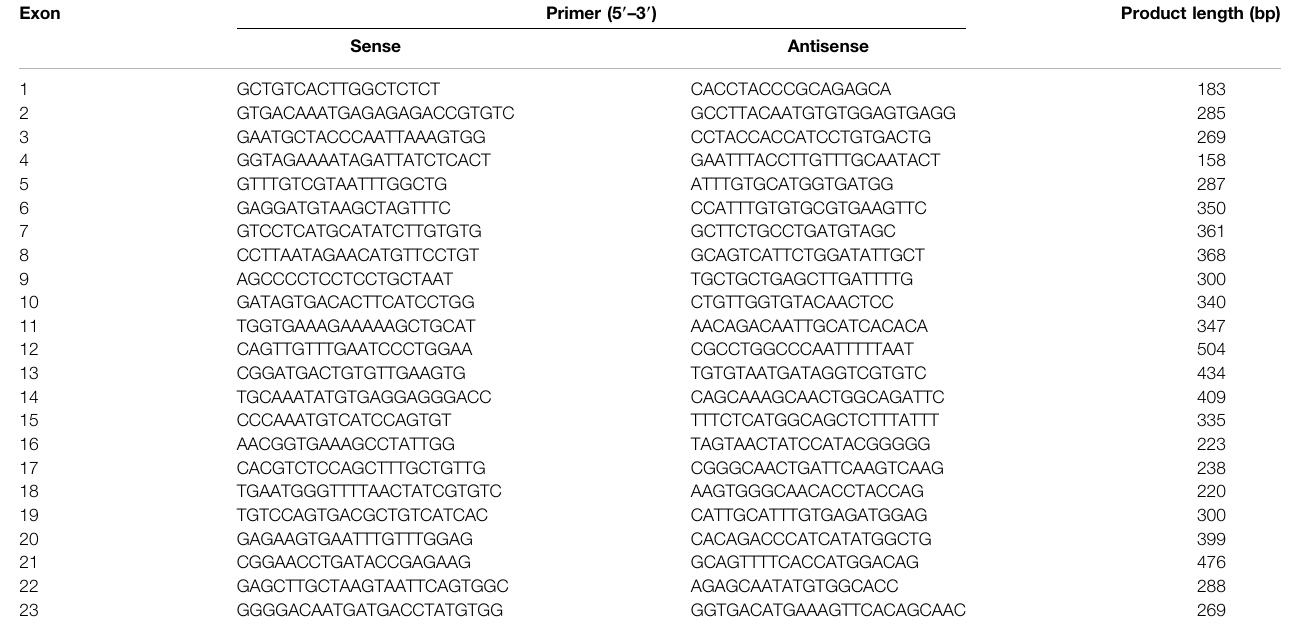
TABLE 3 | Polymerase chain reaction primers used to amplify sequences of the human DPYD gene used in this study.